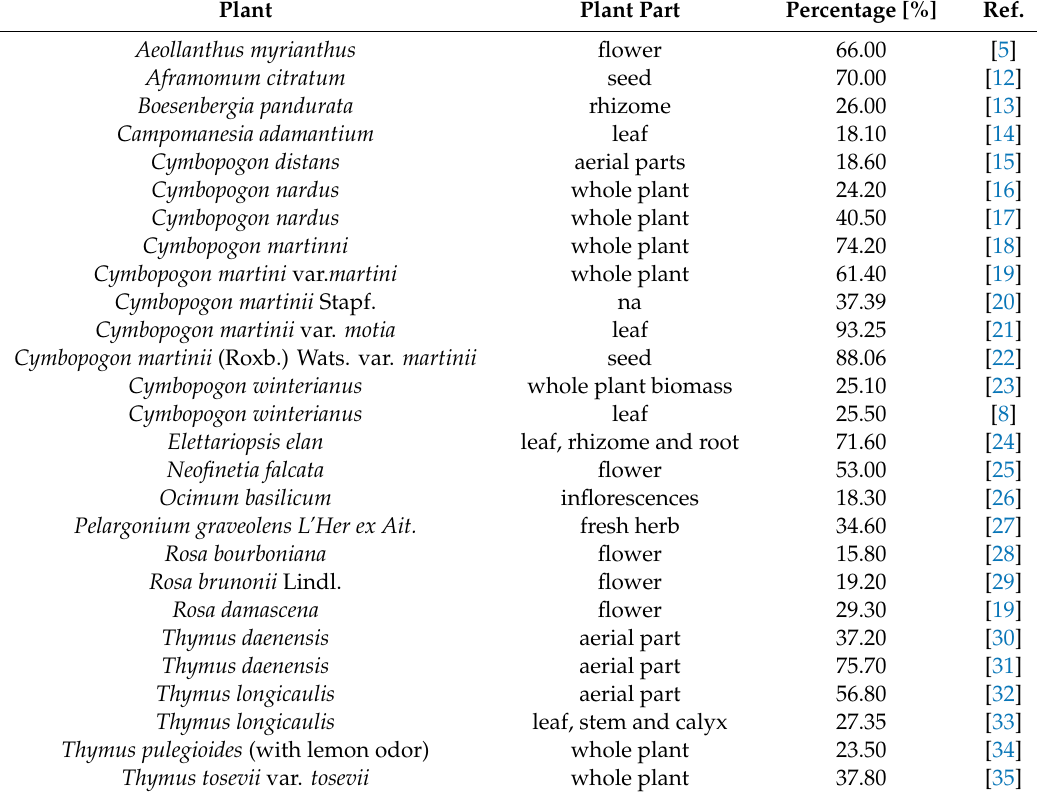
Table 1. Plant resources of